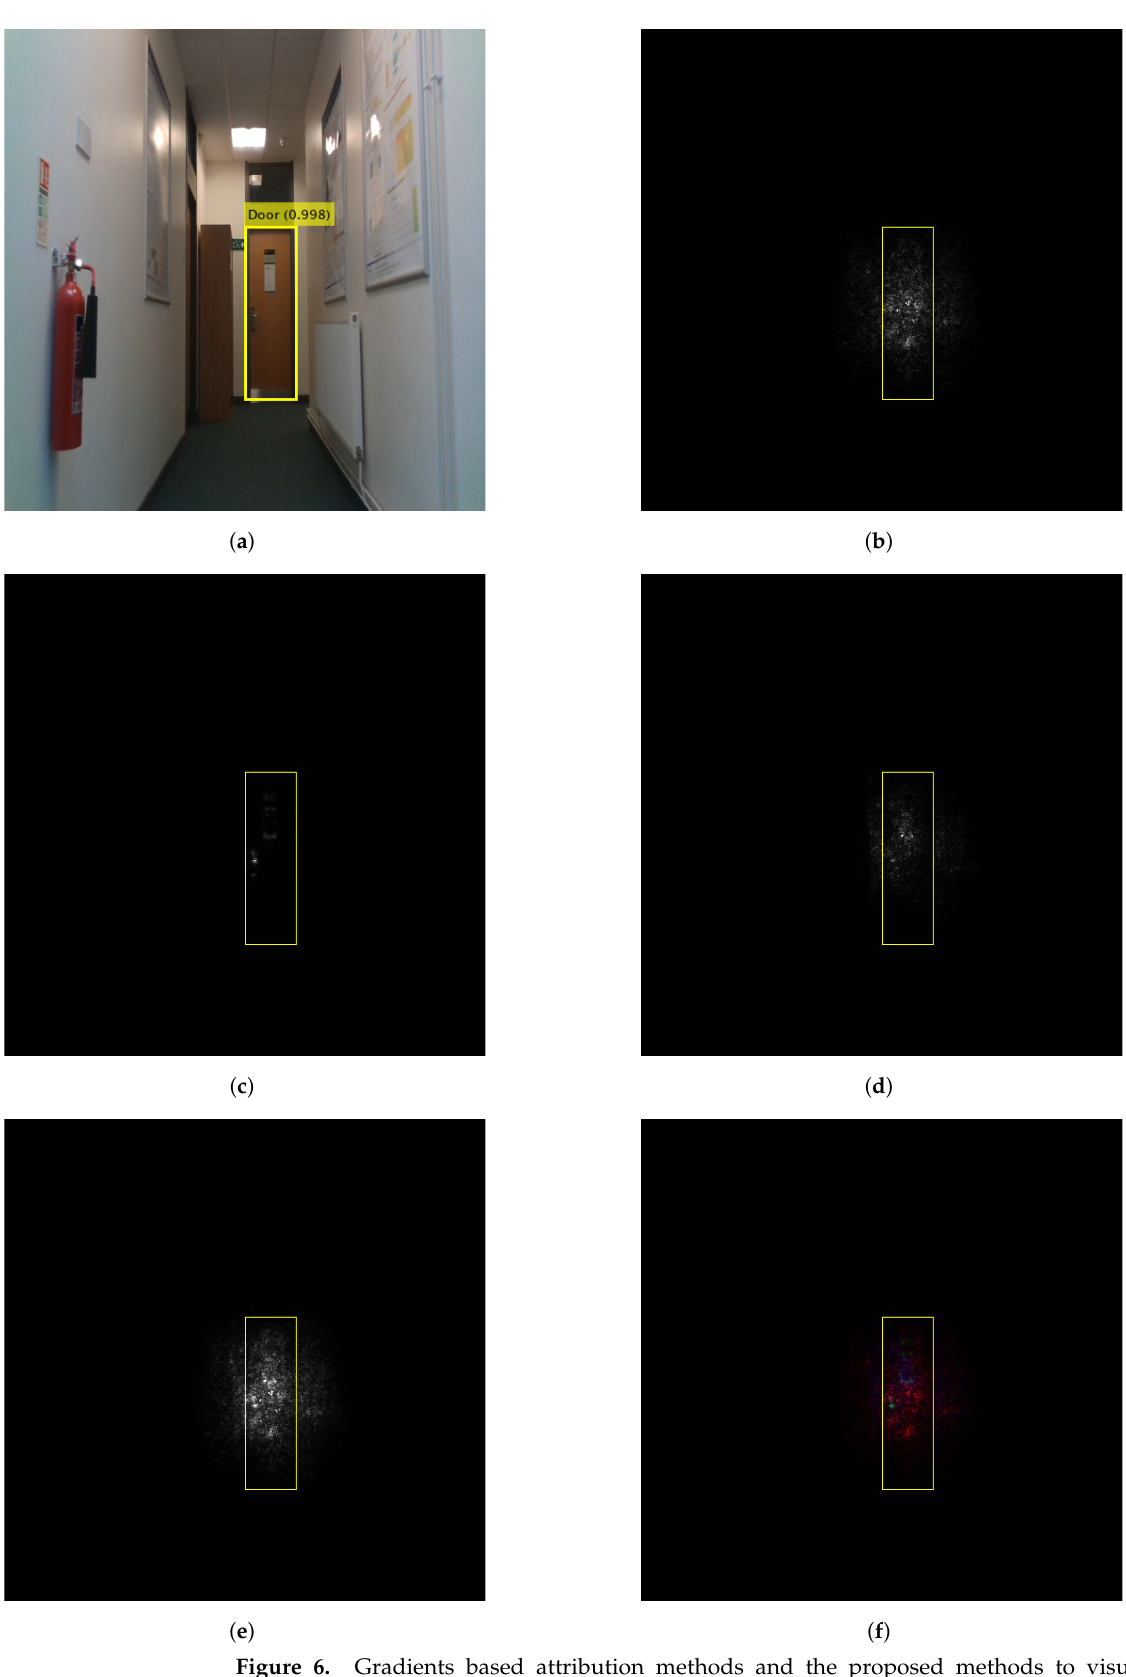
Figure 6. Gradients based attribution methods and the proposed methods to visualise the door prediction using YOLO